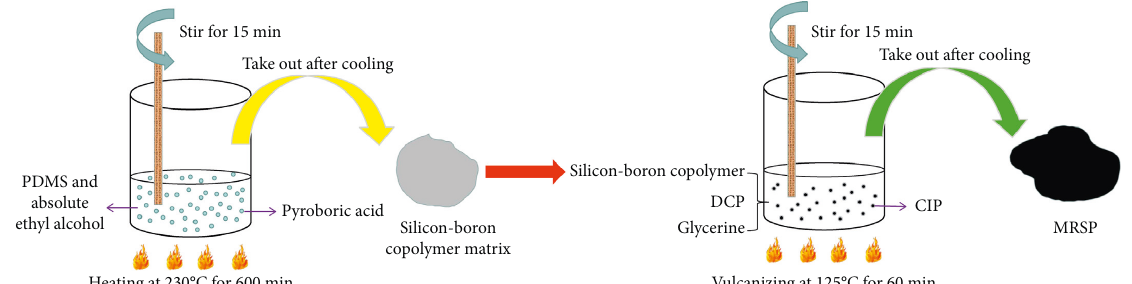
Figure 2: The operation process of silicon-boron copolymer and